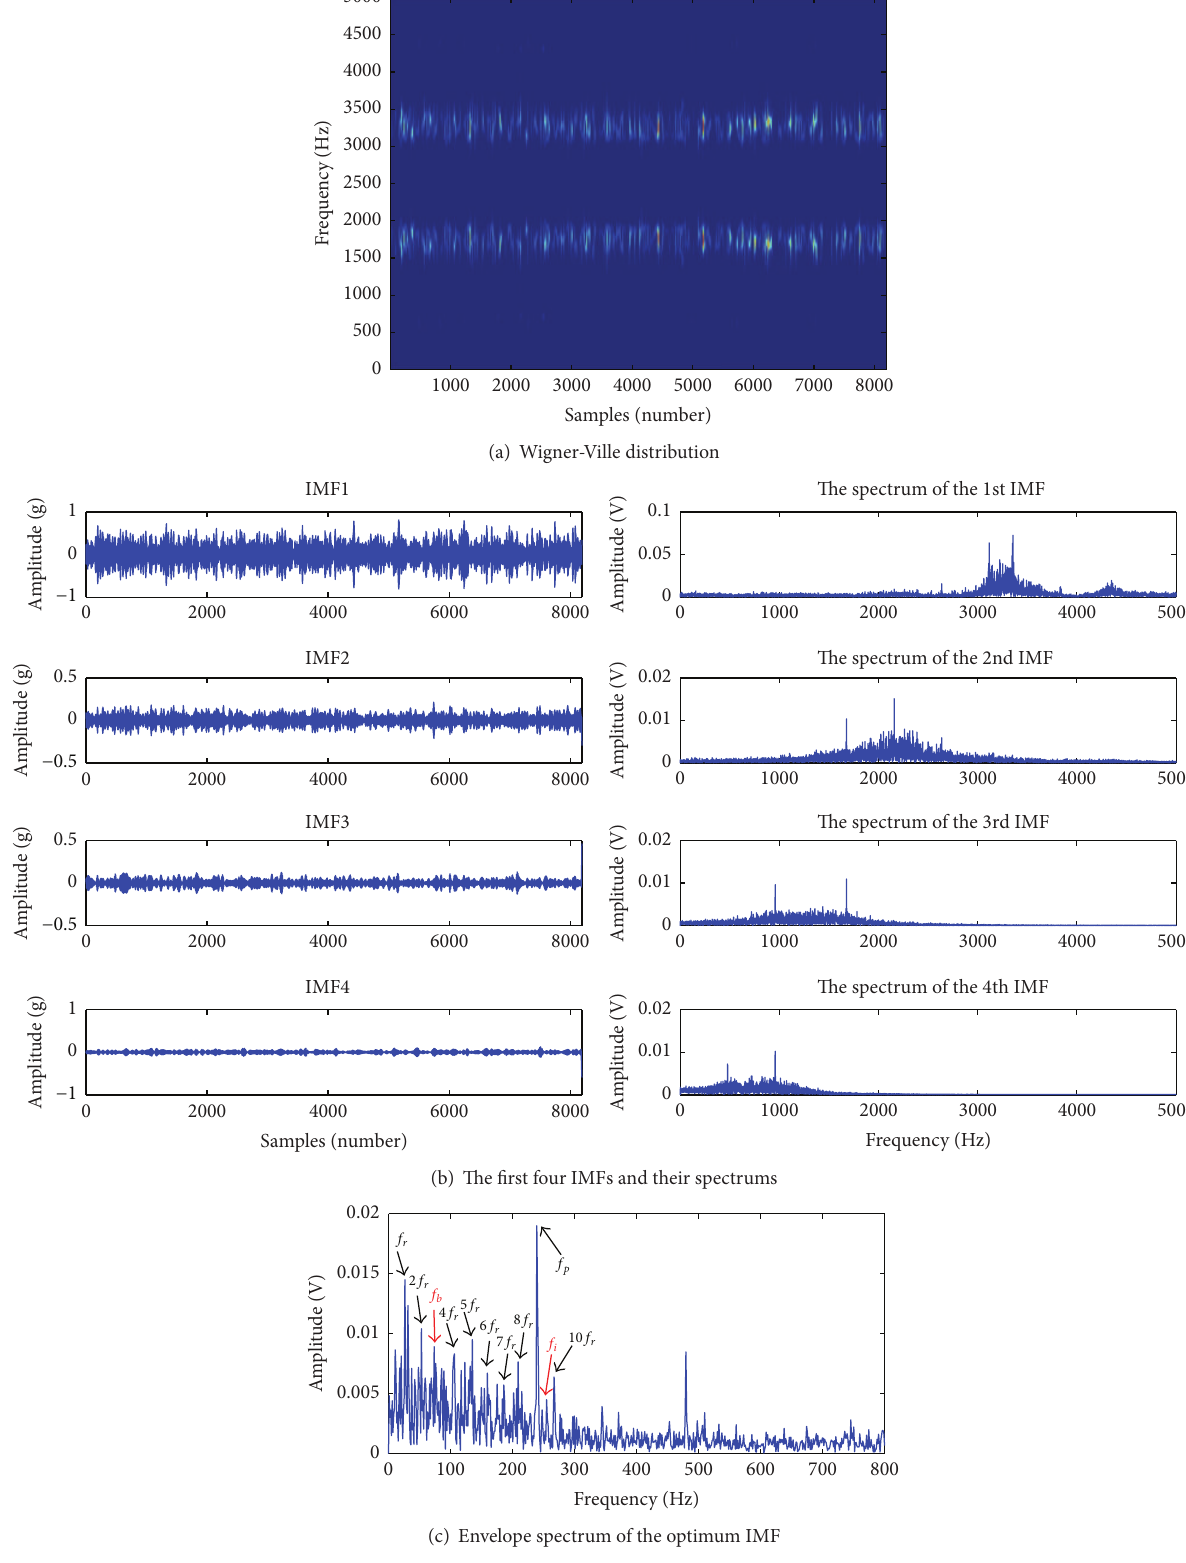
Figure 5: Bearing compound fault diagnosis by envelope analysis for optimum